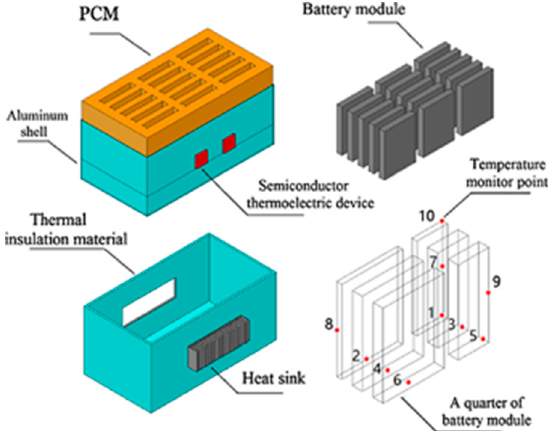
Figure 10. A classic example of hybrid BTMS of PCM coupled with TEC. Reprint with permission [77]; 2020, Elsevier.